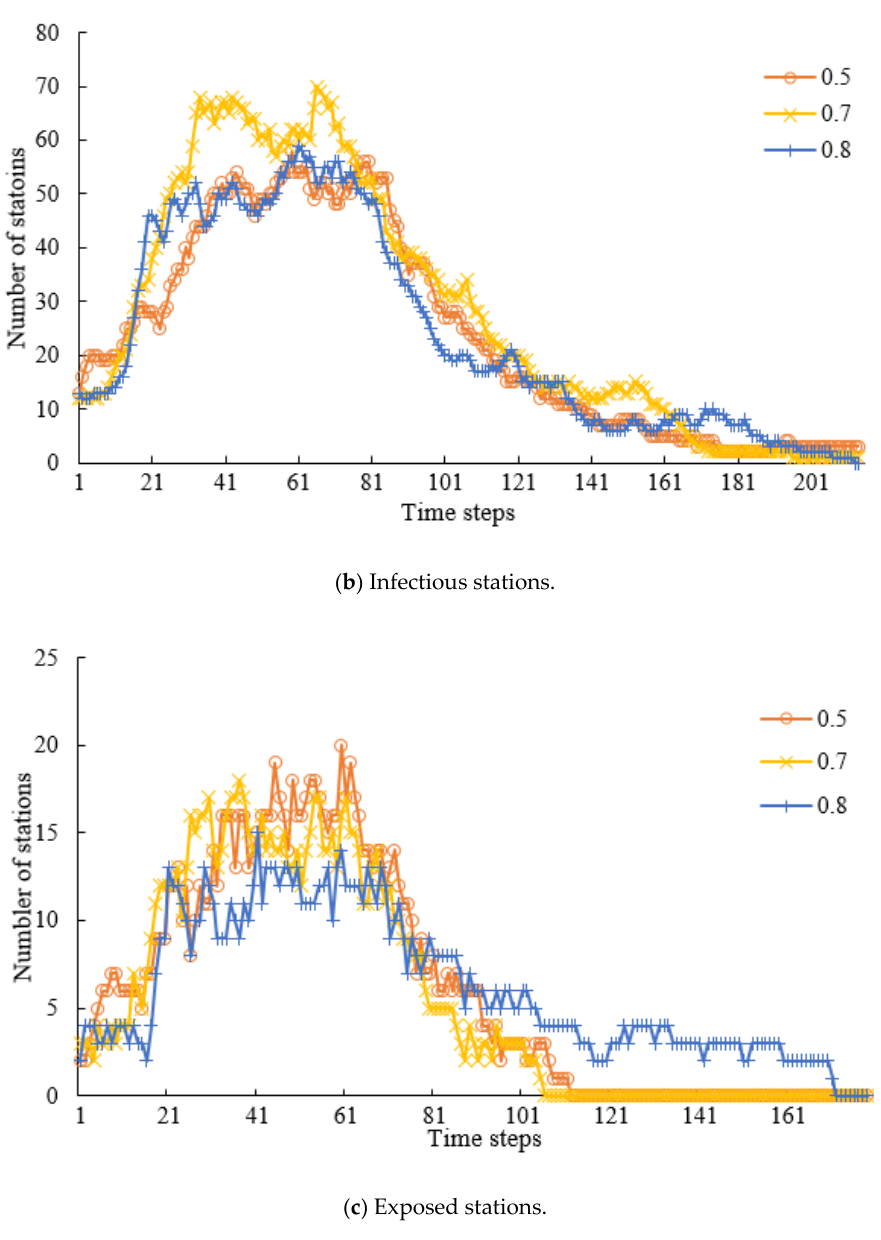
Figure 9. Stations’ states in ASEIR simulation.